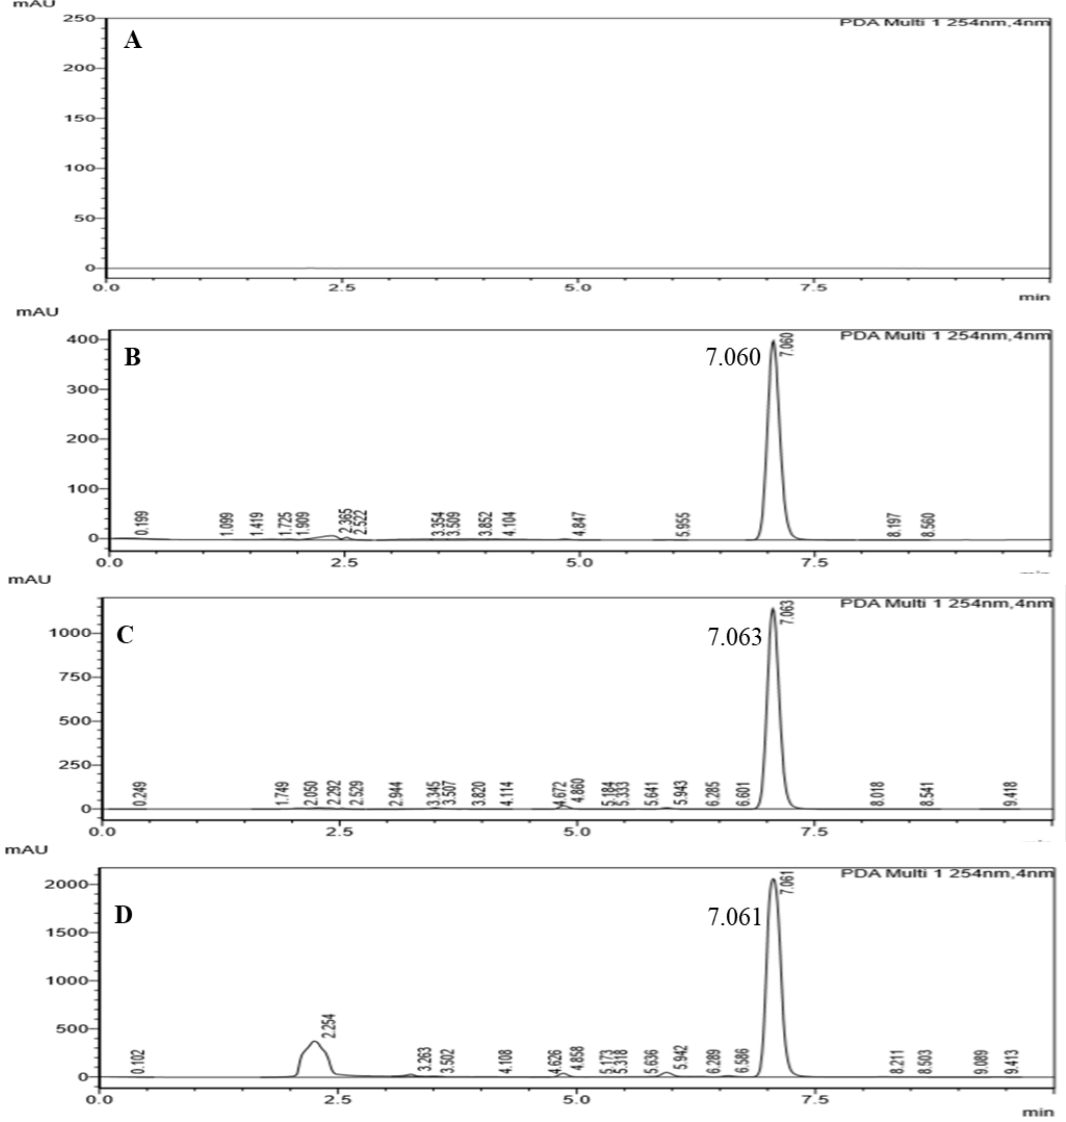
Figure 8. HPLC chromatographs of ( A ) Blank, ( B ) Standard TQ, ( C ) BSO-loaded beads and ( D ) BSO.